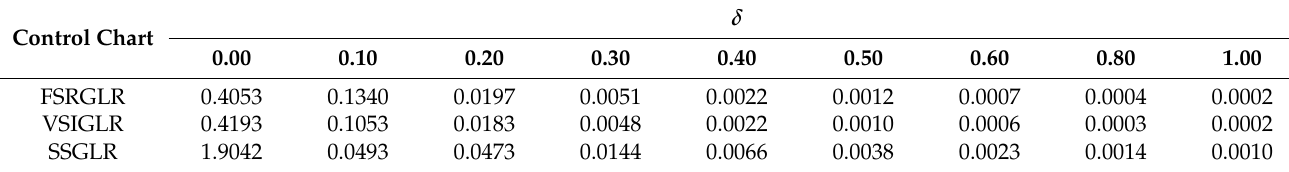
Table 4. The average time of simulations for each run of the FSRGLR, VSIGLR, and SSGLR control charts ( m = 400 and ATS 0 =